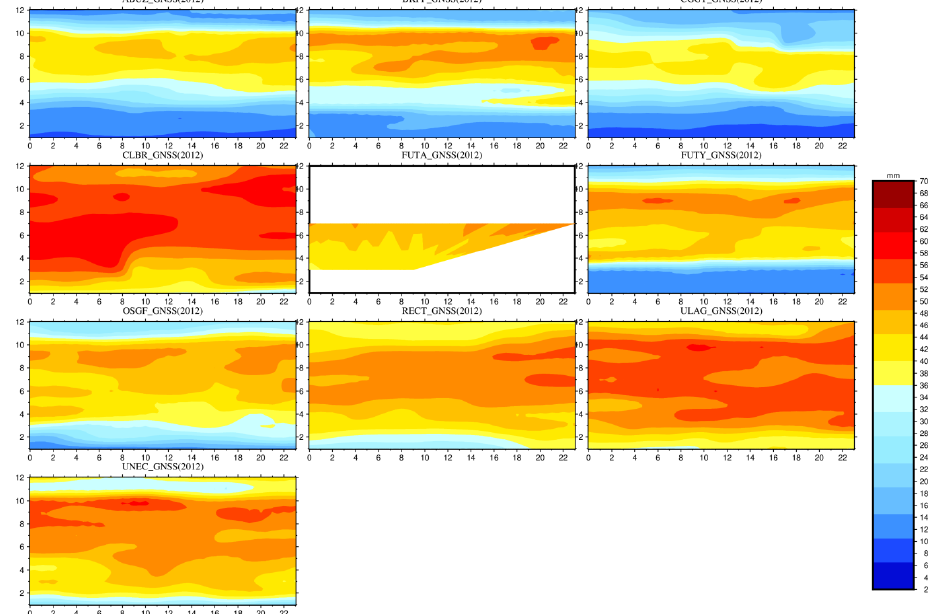
Figure 5. Sub-daily variation of GNSS PWV (mm) over 15 CORS for year 2012, plots are months against time (UTC hours)